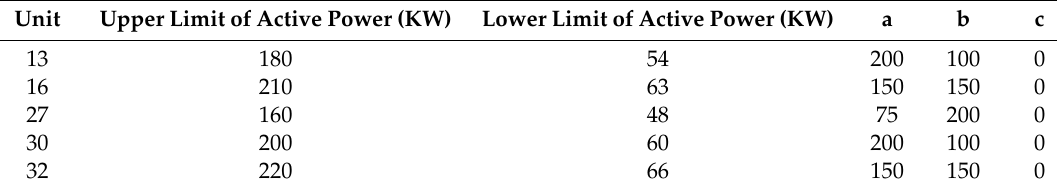
Table 1. IEEE-33 bus system gas turbine parameters.